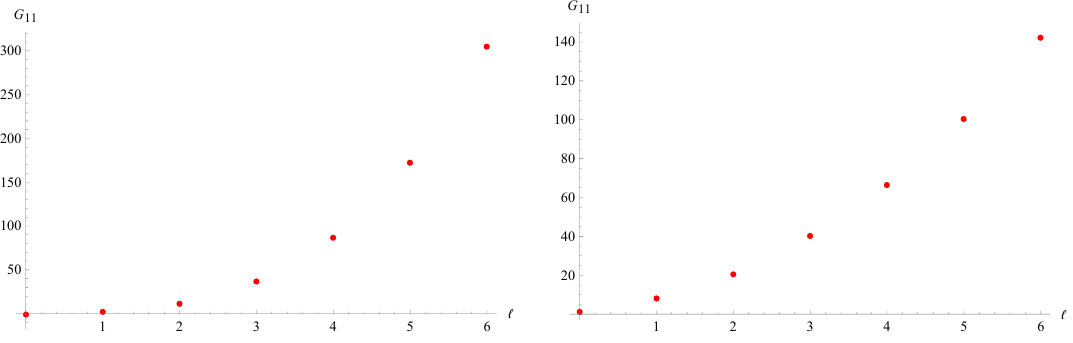
Figure 7 . Left: the 1 (cid:0) 1 correlator with m = 1 ; B = 1 as a function of l (irrelevant). Right: the 1 (cid:0) 1 correlator with m 2 = (cid:0) 1 ; B = 1 as a function of l (relevant). They resemble the analytic correlator of AdS 2 in that they grow in the UV and saturate to a small (cid:12)nite non zero minimum in the